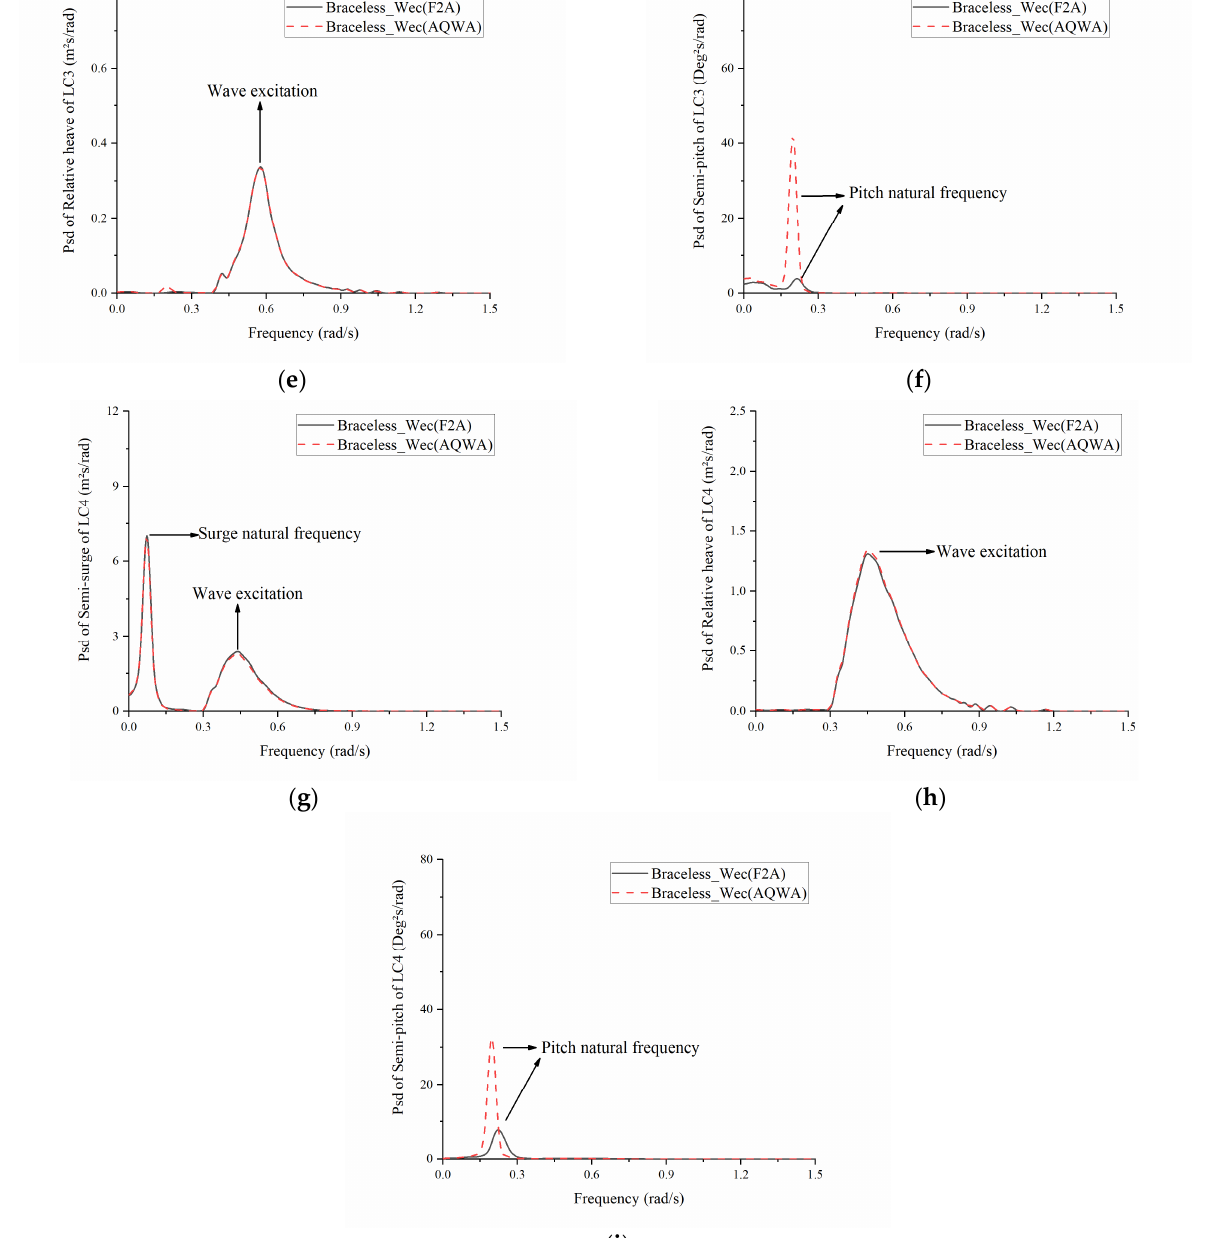
Figure 13. Comparisons of the PSD of the motion for LC2, LC3, and LC4: ( a ) Surge Motion of LC2; ( b ) Relative Heave Motion of LC2; ( c ) Pitch Motion of LC2; ( d ) Surge Motion of LC3; ( e ) Relative Heave Motion of LC3; ( f ) Pitch of LC3; ( g ) Surge Motion of LC4; ( h ) Relative Heave Motion of LC4; ( i ) Pitch Motion of LC4.